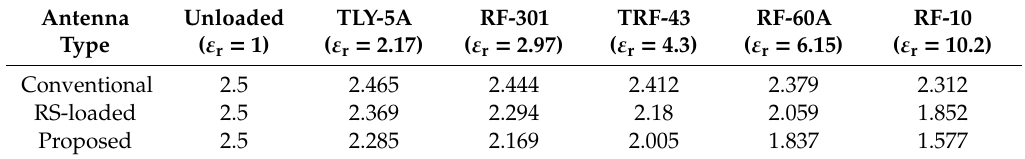
Figure 9. Simulated S 11 characteristics of the three MPSAs for MUTs in Table 2: ( a ) conventional MPSA; ( b ) RS-loaded MPSA; and ( c ) proposed MLS-loaded MPSA. Table 3. Simulated first resonant frequencies for S 11 responses in the three MPSAs in GHz.